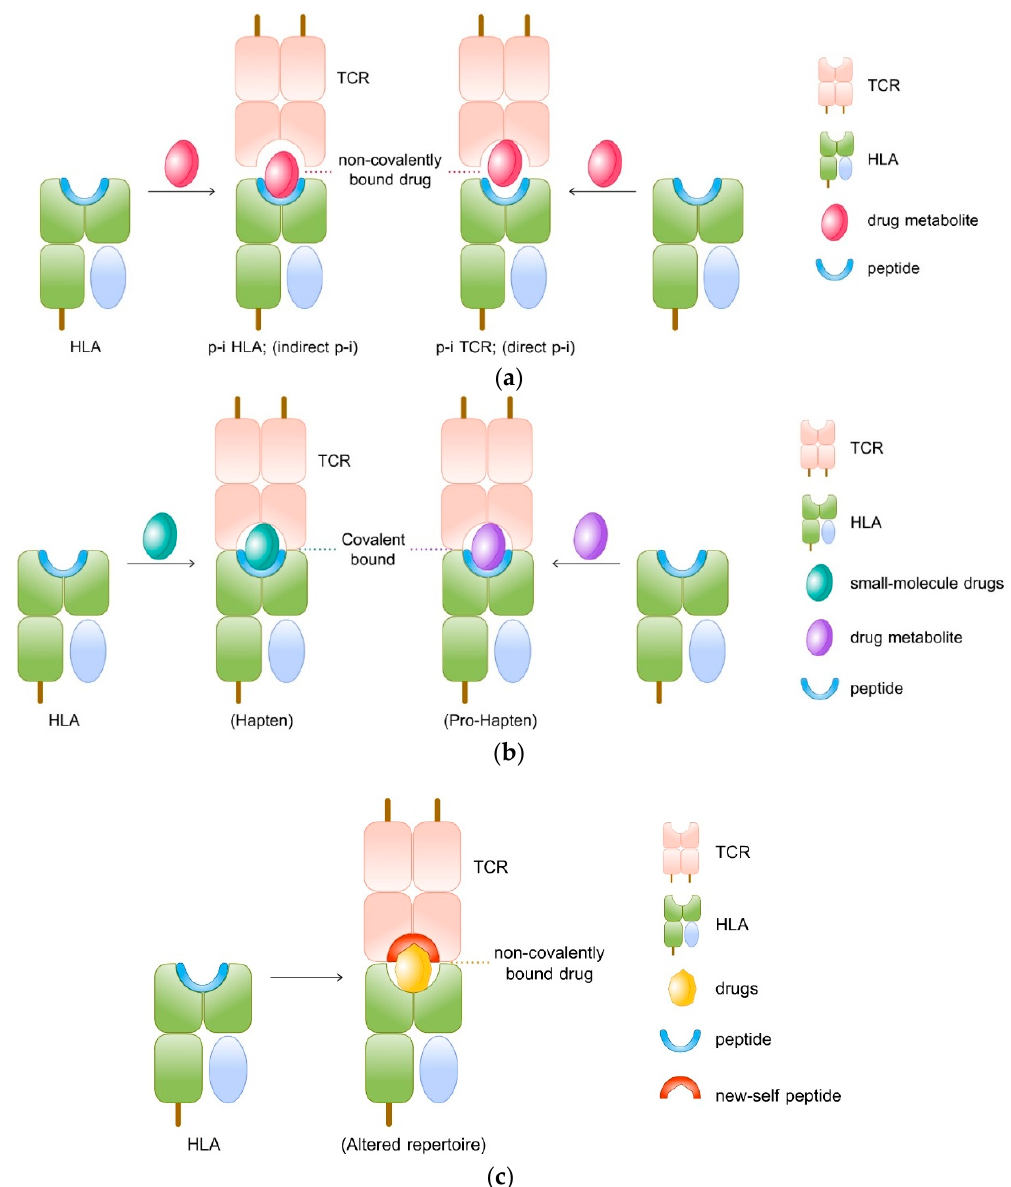
Figure 3. The mechanisms behind drug-induced delayed hypersensitivity reaction (DHS) are explained in three different theories ( a ) hapten/prohapten theory, ( b ) pharmacological interaction theory (p-i), and ( c ) repertoire alteration theory.